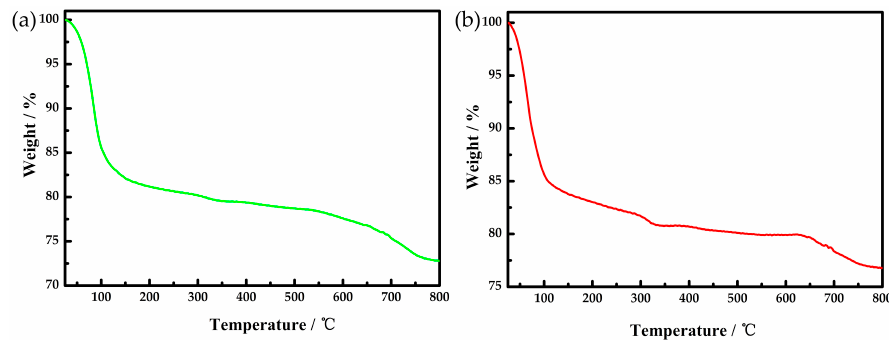
Figure 3. ( a ) The TGA curve of compound 1 ; ( b ) The TGA curve of compound 2 .